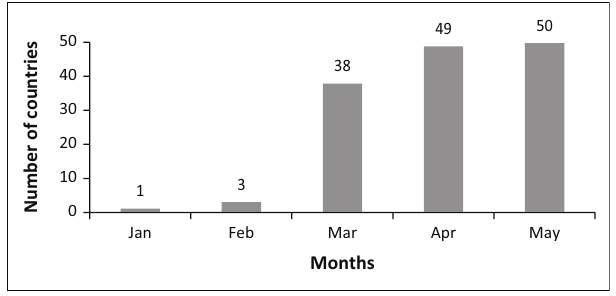
FIGURE 1 : The total number of sub-Saharan African countries reporting coronavirus testing results or laboratory testing capacity, January 2020 –